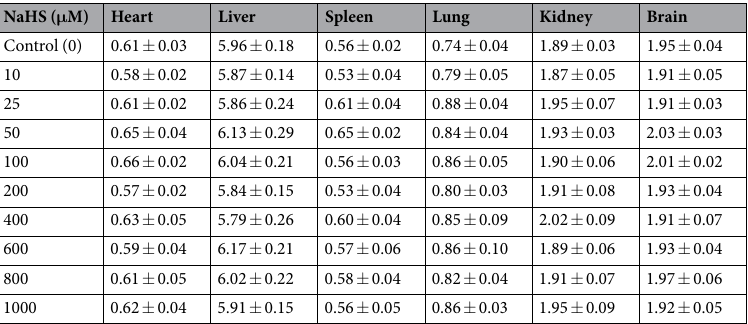
Table 2. Relative organ weight of nude mice bearing Huh-7 xenograft after the subcutaneous administration of NaHS for 14